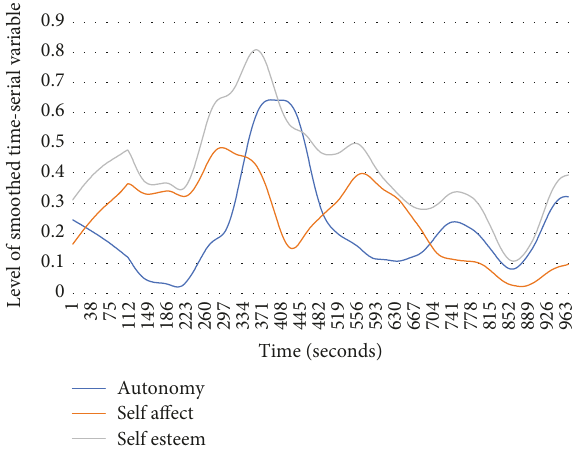
Figure 4: Example of an individual ’ s lower-order time-serial variables (self-a ff ect and autonomy) and their state self-esteem time